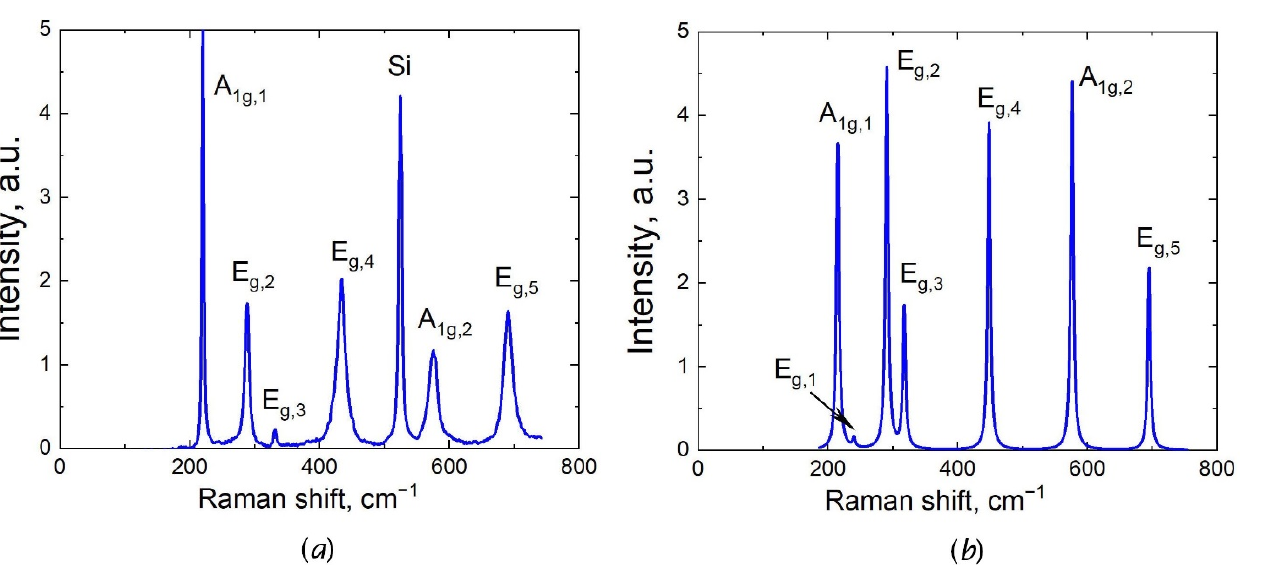
Figure 15. The Raman spectrum of the α -Ga 2 O 3 /SiC/Si sample, in confocal geometry, excluding birefringence ( a ). The theoretical Raman spectrum of α -Ga 2 O 3 , excluding birefringence, as calculated by the DFT method ( b ).